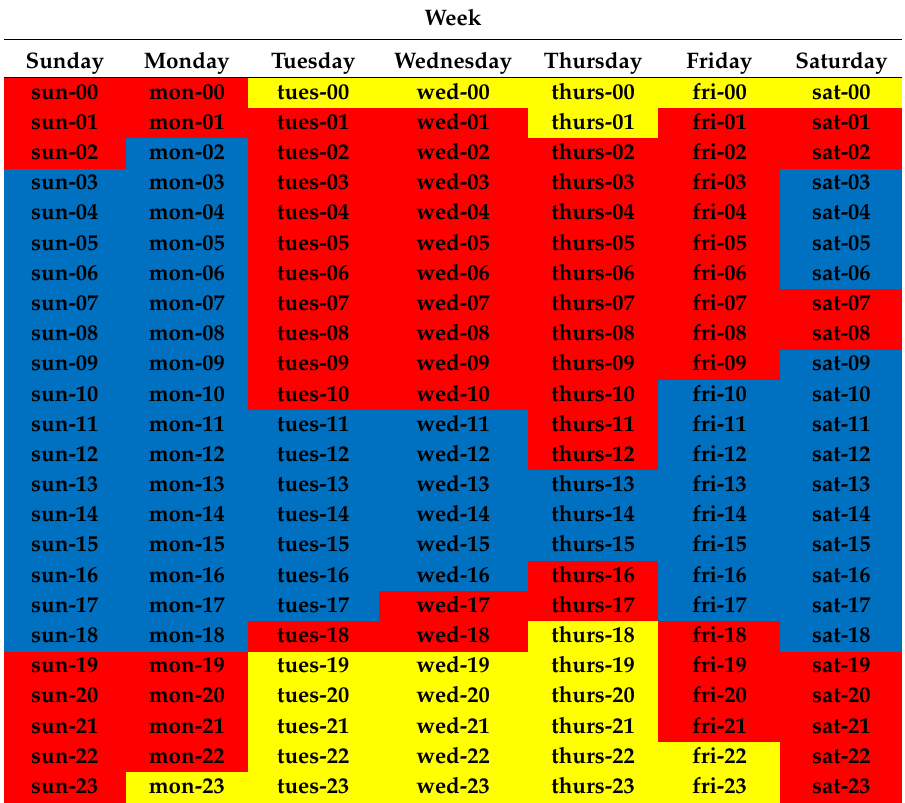
Table 5. Representation of the cluster analysis during the average week of the entire period (day-hour). The di ff erent colors represent the three